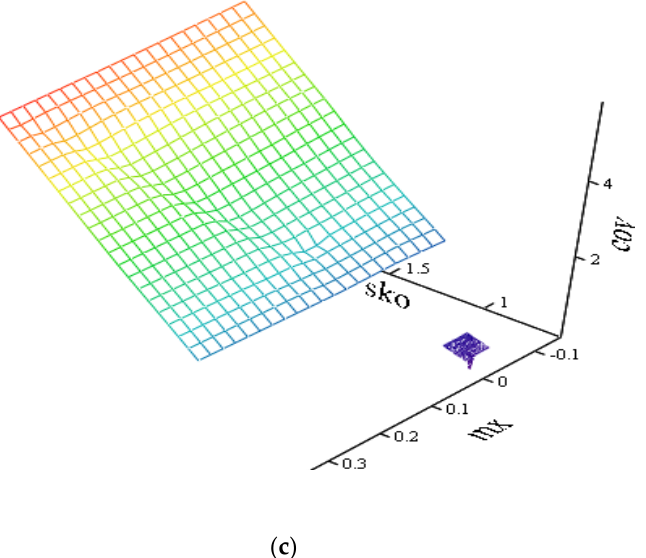
Figure 6. Graphs of standard deviation, mathematical expectation and covariance. The color plane is the range of the legitimate traffic values and purple is the range of the additive mixture values: ( a ) At the second iteration; ( b ) at the third iteration; ( c ) at the fourth iteration.